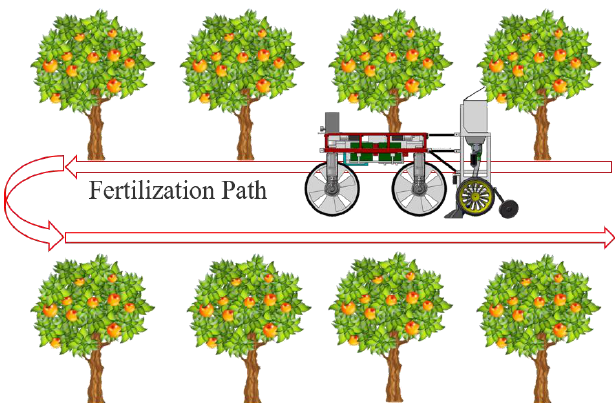
Figure 1. Schematic diagram of fertilization operation in an orchard.